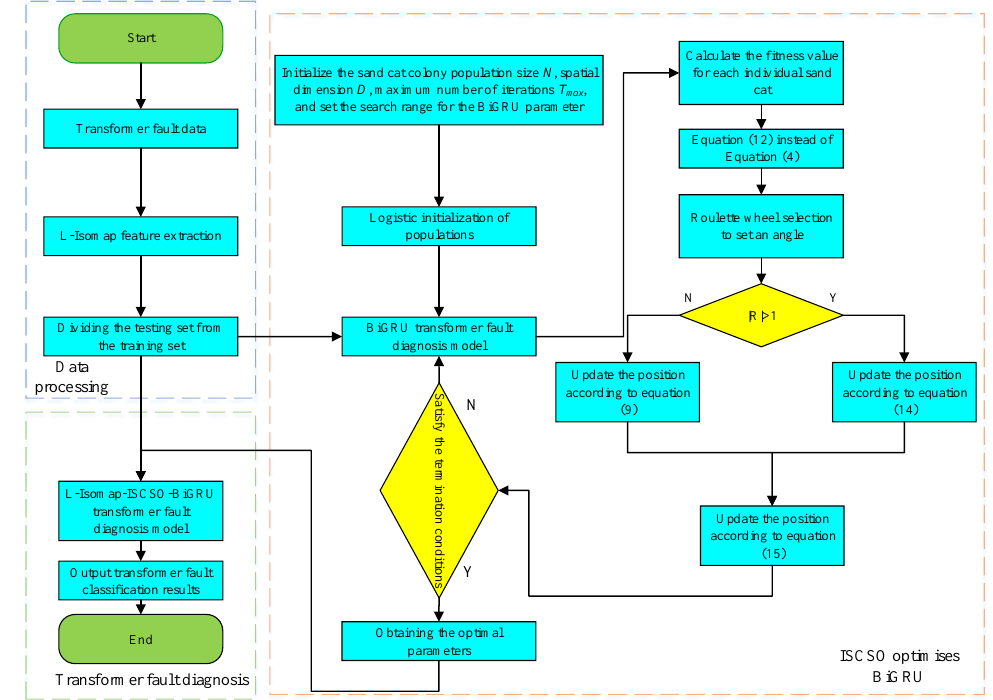
Figure 15. Fault diagnosis model based on L-ISOMP-ISCSO-BIGRU.